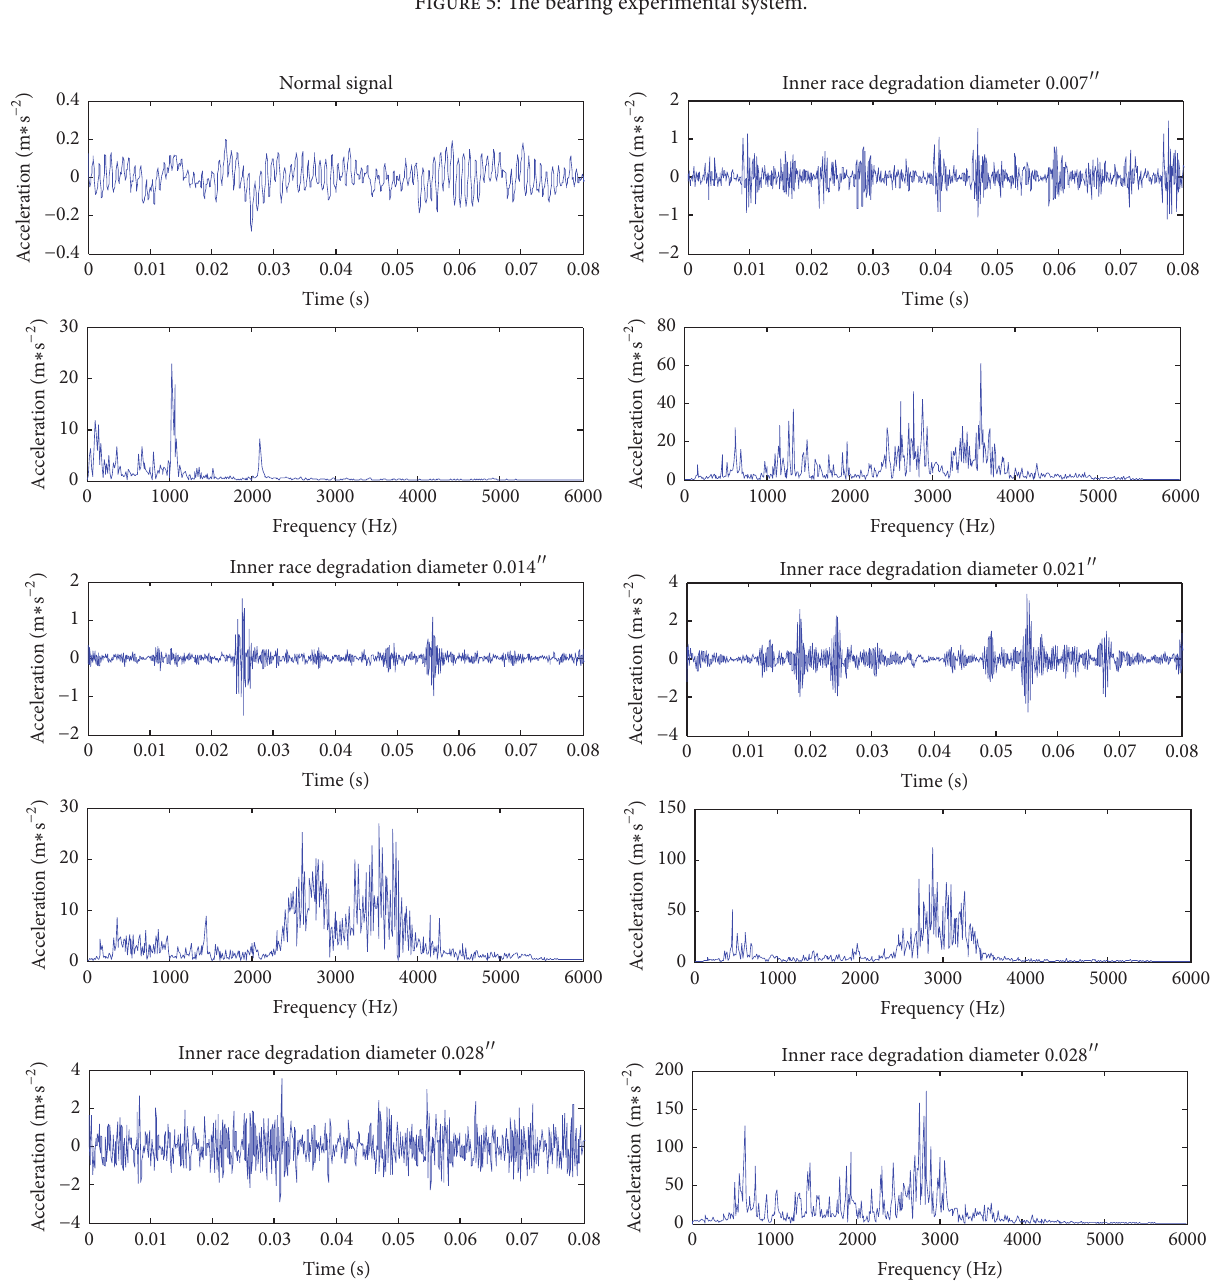
Figure 6: Time domain and frequency spectrum of five-degradation state vibration signal of the motor